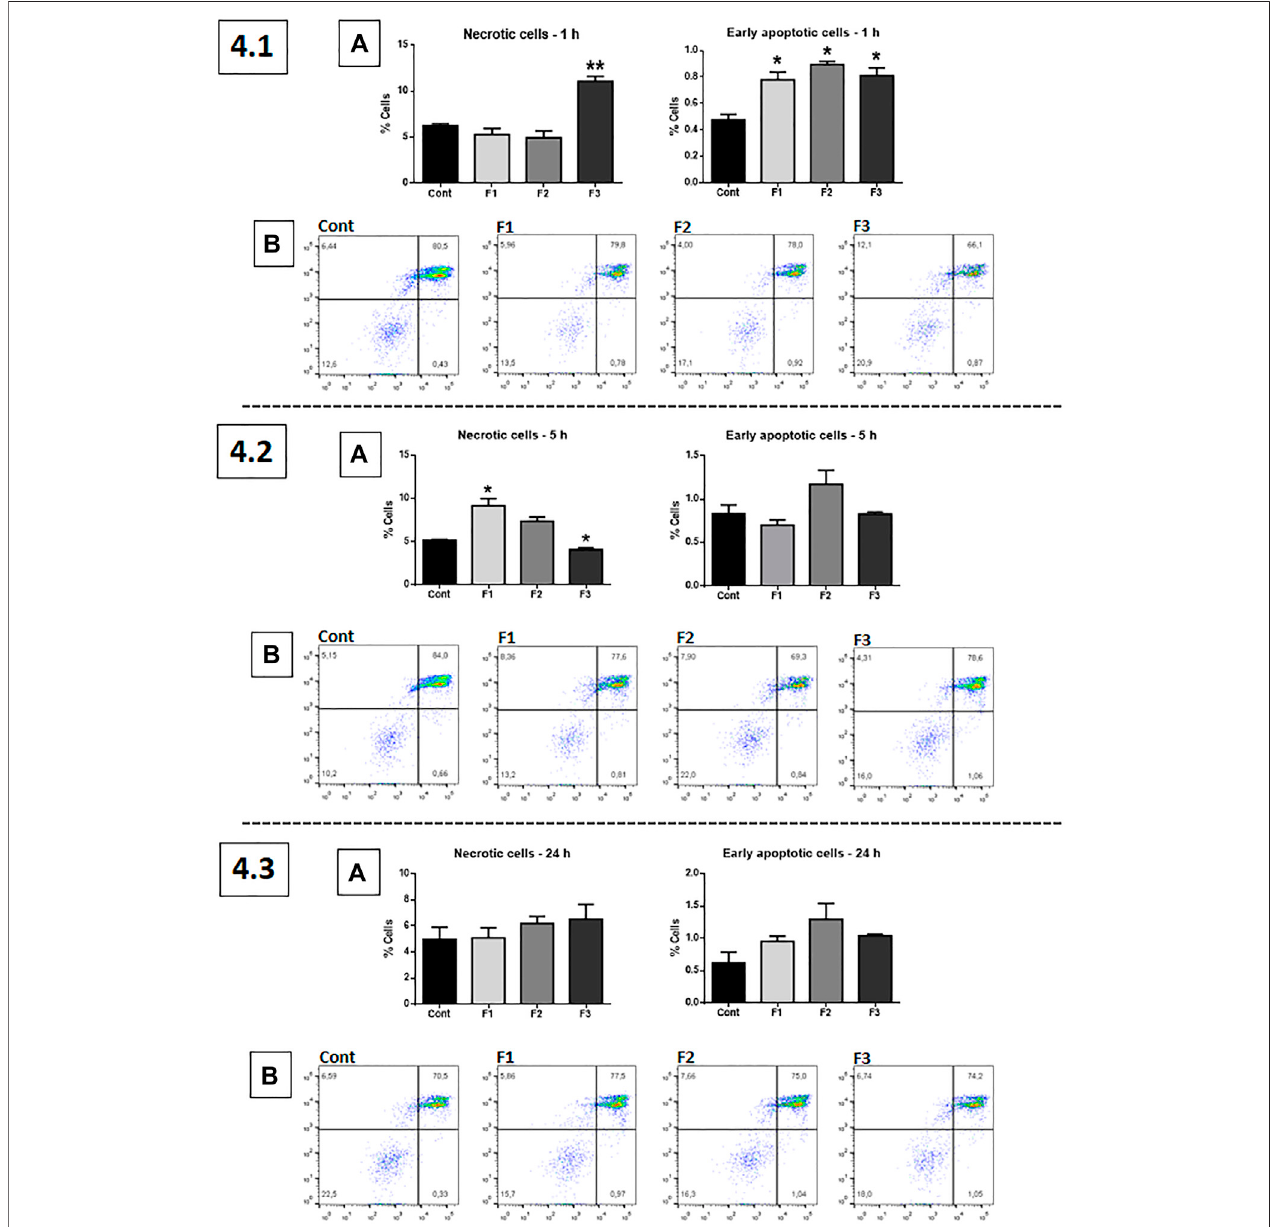
FIGURE4| Apoptosis/necrosisassay(AnnexinV/PI):humanGBcellstreatedwithF1,F2,andF3at0.1 μ g/ml.4.1 (A) After1 hoftreatment,F3inducedsigni fi cant increase of GB cell necrosis, compared to the untreated control, whereas F1, F2, and F3 induced apoptosis in this time point. 4.2 (A) After 5 h of treatment, F1 and F2 inducedsigni fi cantnecrosis,whileF2appearstoinduceapoptosis,althoughnotsigni fi cantly.4.3 (A) After24 hofexposure,nosigni fi cantdifferenceswereobserved. (B) 4.1, 4.2, and 4.3 show representative histograms. One-way ANOVA followed by Dunnett ’ s multiple comparisons test; unpaired Student ’ s t-tests were used to compare each treatment with the control. * p < 0.05, ** p < 0.01, compared to the control